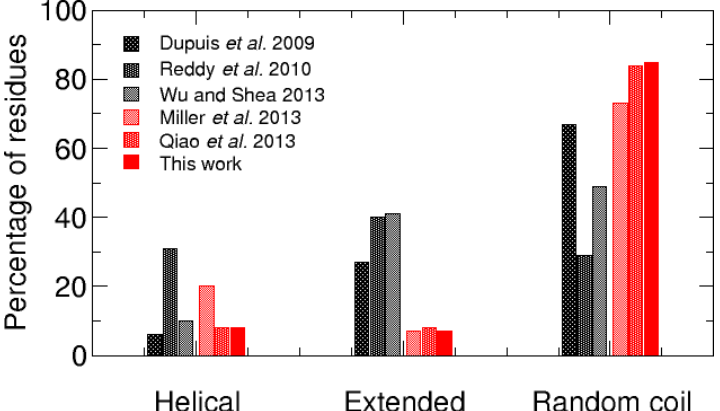
Figure 8. Comparison of the averaged percentage of the residues found in helical ( left ), extended ( middle ) and random coil ( right ) secondary structures for the amidated hIAPP ( grey bars) [31,35,39] and its non-amidated form ( red bars)